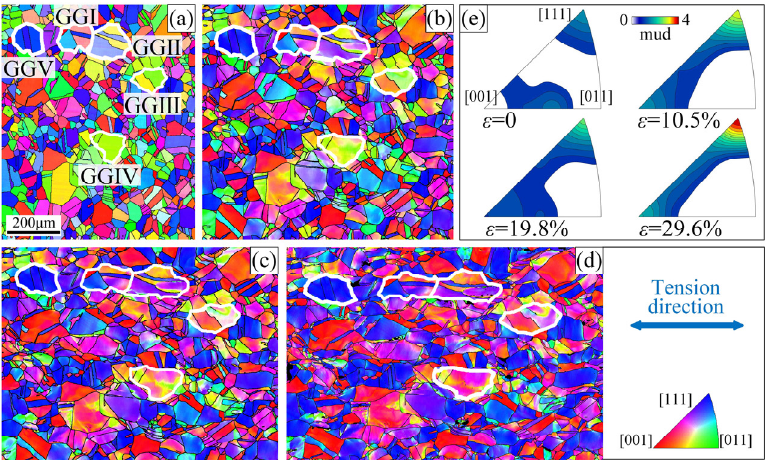
Figure 3. ( a – d ) OIM at strain values of 0, 10.5%, 19.8%, and 29.6%, respectively. ( e ) Inverse pole figures along RD direction at strain values of 0, 10.5%, 19.8%, and 29.6%,